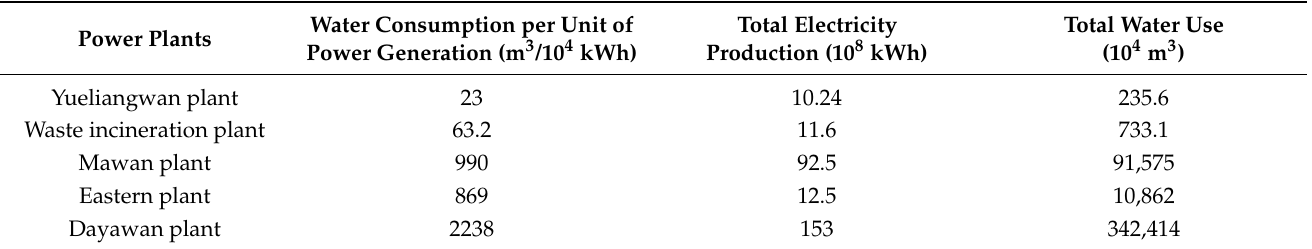
Table 2. Relationships between total power generation and total water use for different power plants in Shenzhen.